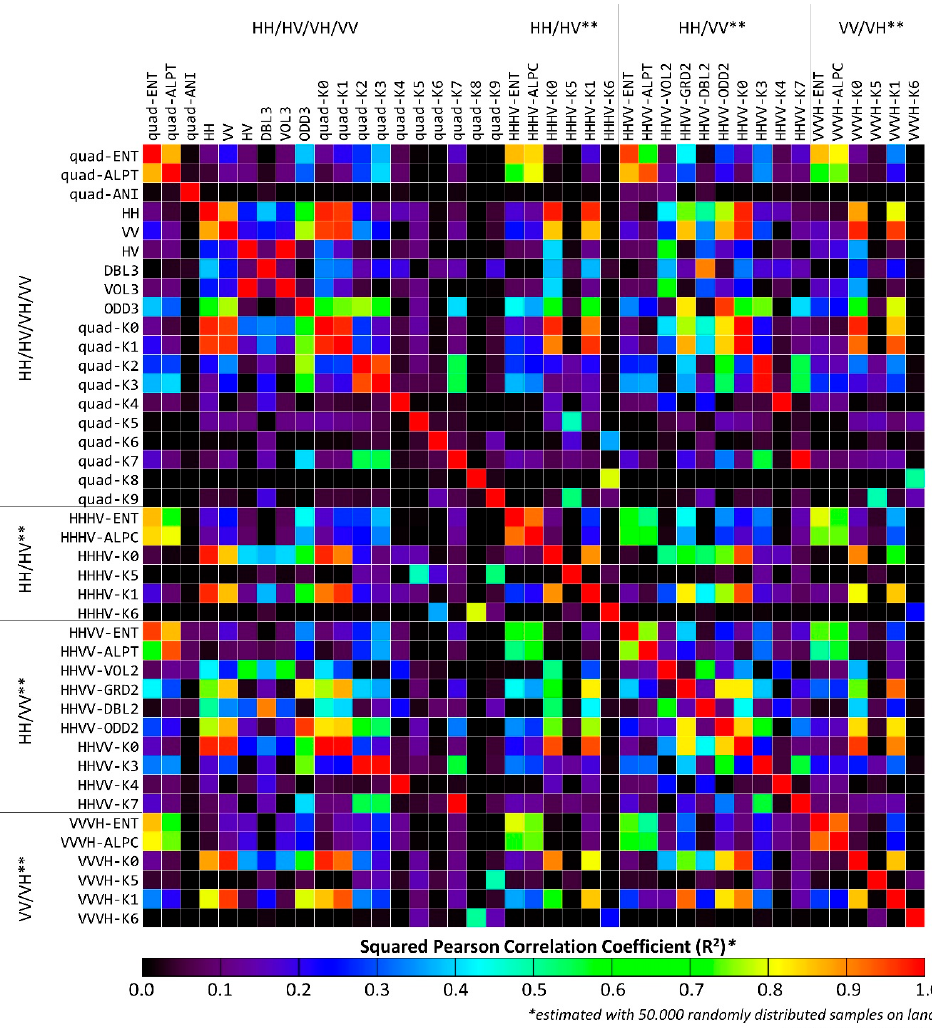
Figure 4. Correlation-Matrix of quad- and dual-polarimetric L-Band ALOS-2 features showing the squared Linear Pearson Correlation Coefficient ( R 2 ) ranging from 0.0 (no correlation) to 1.0 (full linear correlation, determination respectively). R 2 was estimated using 50,000 randomly distributed samples on land (roughly 10% of all land pixels). Note that dual-polarimetric data of ALOS-2 were derived as polarimetric subsets and thus are not affected by temporal variations. Feature abbreviations are